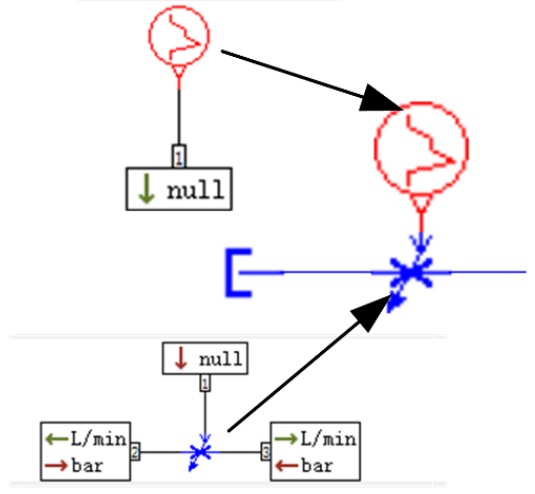
Figure 5. Load model.